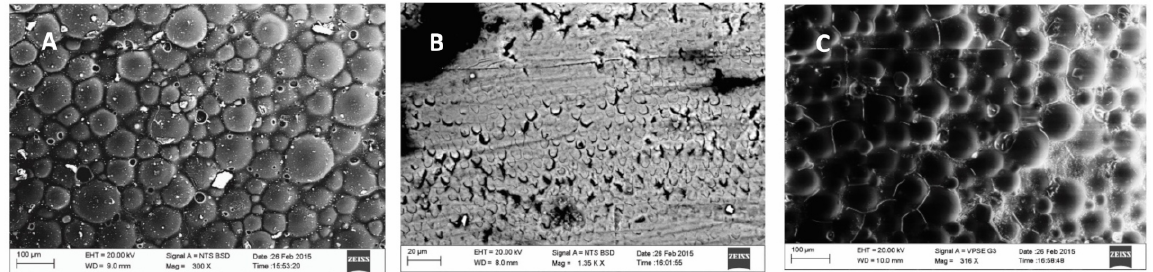
Figure 2. Scanning electron microscopy images ( A ) Normal enamel surface; ( B ) Demineralised enamel; ( C ) P11-4 treated enamel surface after demineralisation [35] (Reproduced with